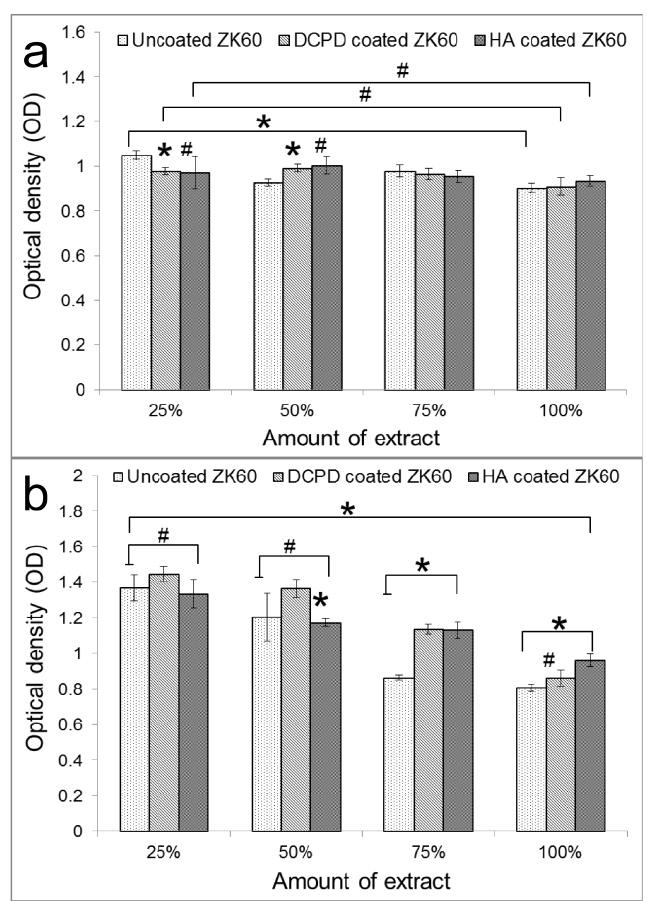
Figure 9. L-929 cell viability expressed by the optical density of the cells using the MTT assay after ( a ) one day and ( b ) three day incubation in uncoated ZK60, DCPD